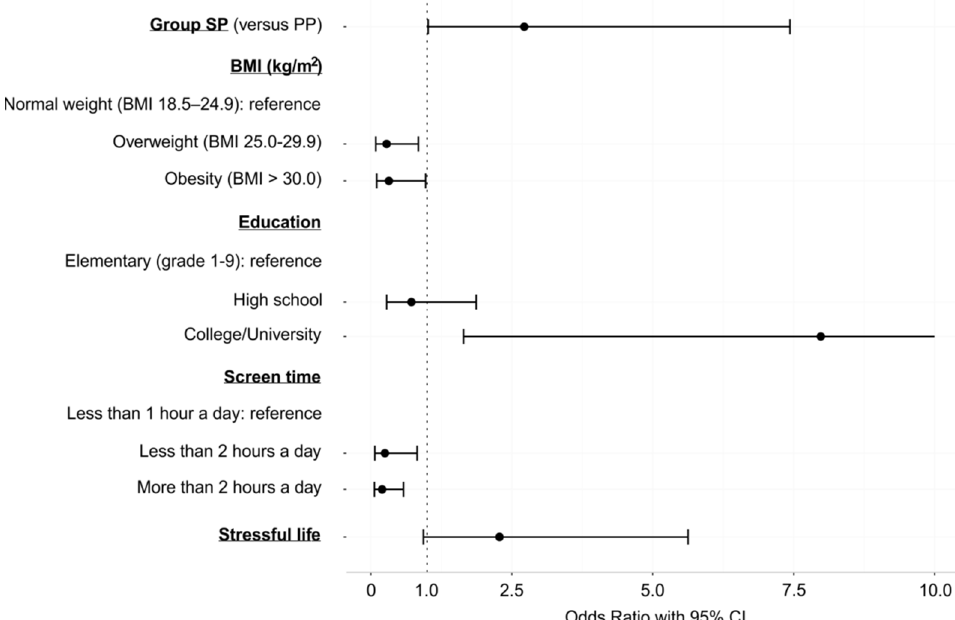
Figure 2. Graphical representation of the results of the final multivariate logistic regression model after stepwise exclusion of variables (Odds Ratios of the appropriate ICD therapy, and the corresponding 95% confidence interval). Note: The confidence interval of the OR for the college/university education level has been truncated at 10.0. The upper value of the interval should be 47.71, but displaying this value in the graph precludes visibility of other results in the graph.